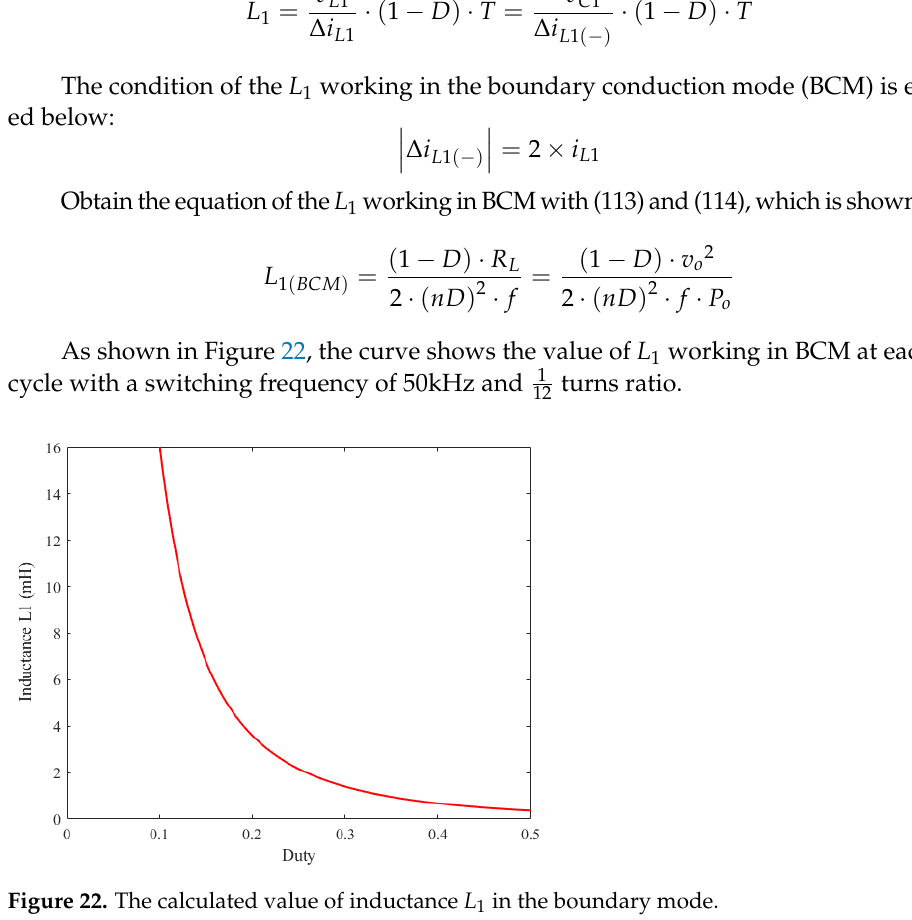
1 in the boundary